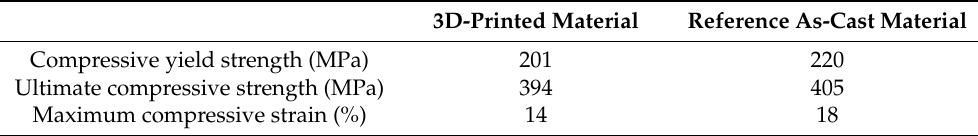
Table 3. Mechanical compressive properties of the 3D-printed material and as-cast reference material.